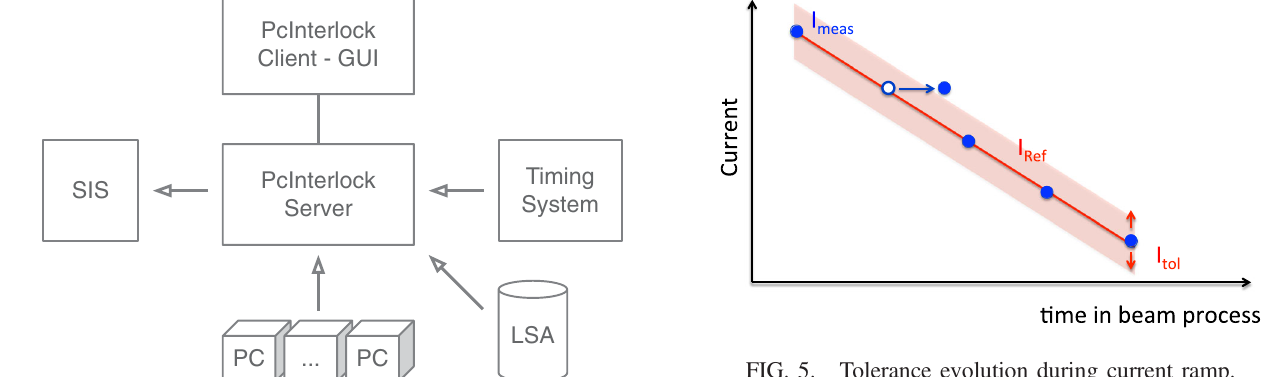
FIG. 5. Tolerance evolution during current ramp.